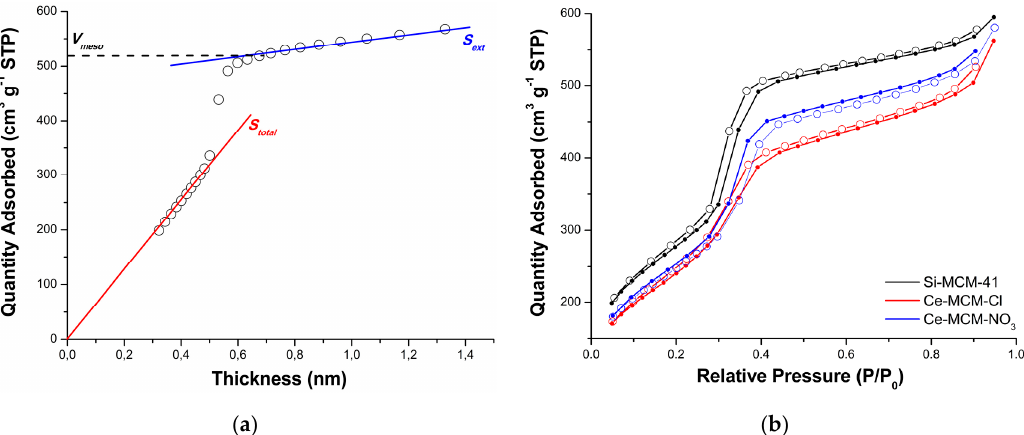
Figure 10. Thickness or t-plot curve for Si-MCM-41 ( a ) where the blue line slope corresponds to S total , the red line slope corresponds to S ext , and the dashed black line intercept with the y -axis corresponds to V meso ; N 2 adsorption / desorption isotherm for Si-MCM-41, Ce-MCM-Cl, and Ce-MCM-NO 3 ( b ) where filled circles correspond to adsorption and hollow circles corresponds to desorption.